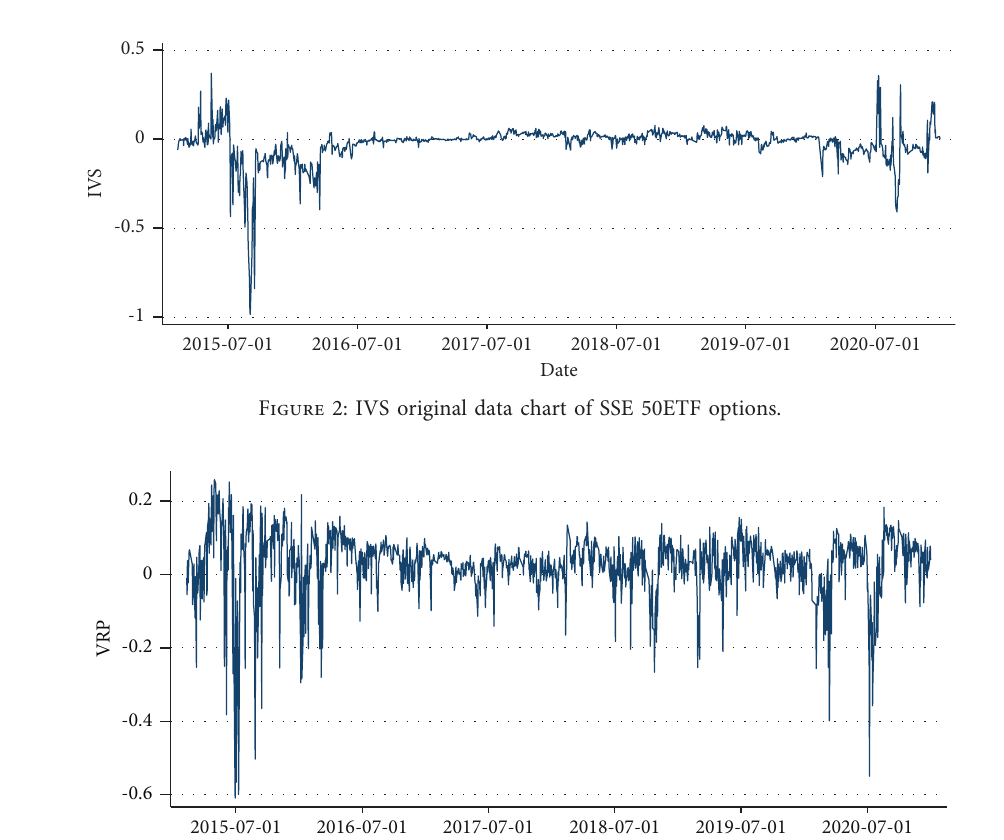
Figure 1: IV original data chart of SSE 50ETF options.